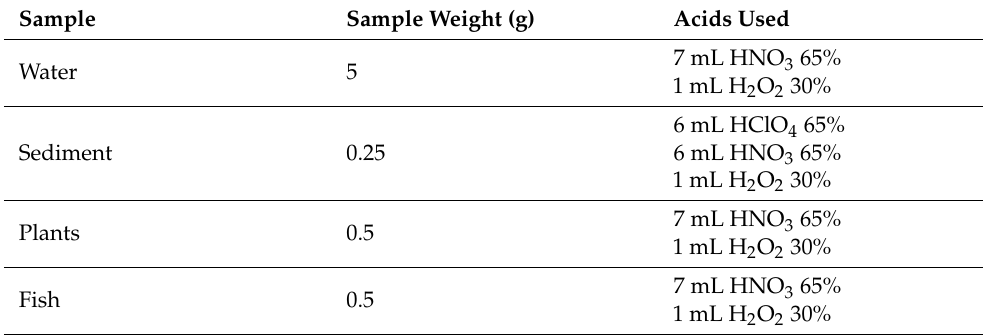
Table 2. Analysis for acid digestion.